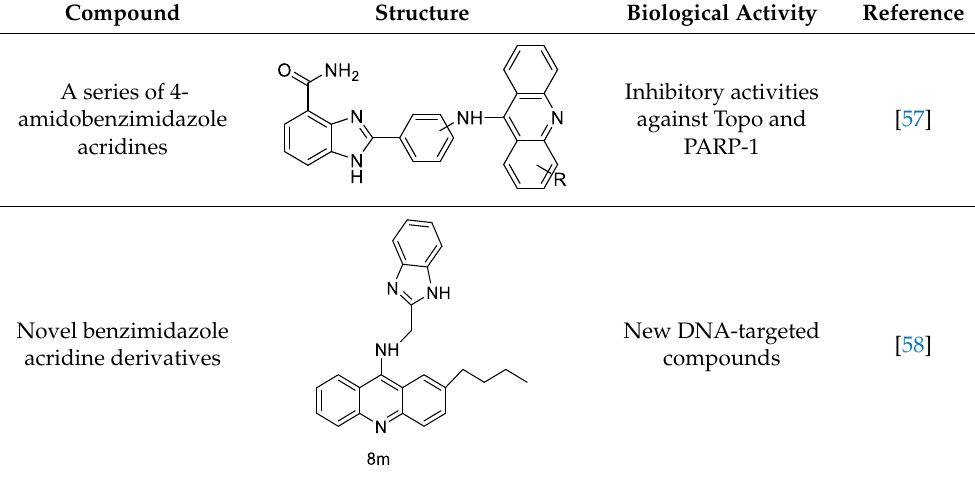
Table 7. Cont. Compound Structure Biological